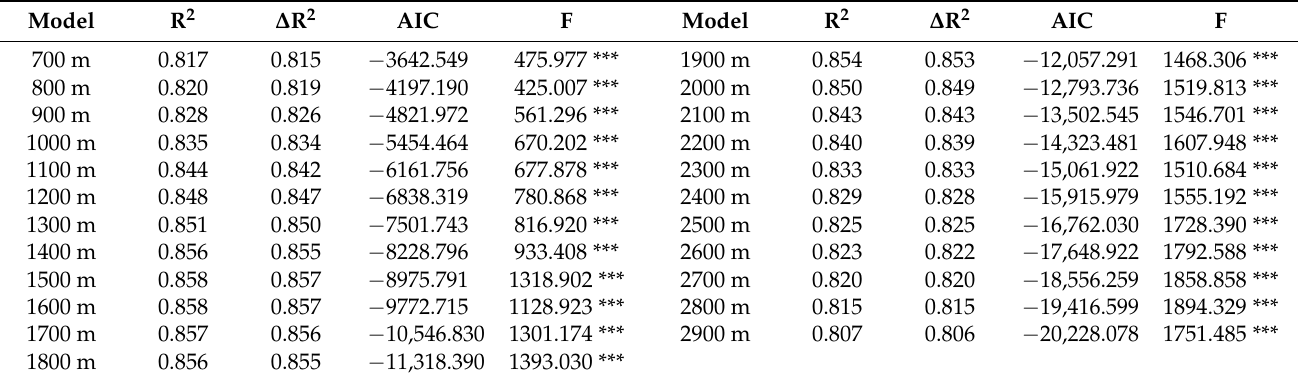
Table 4. Significance tests of the multiple linear regressions in